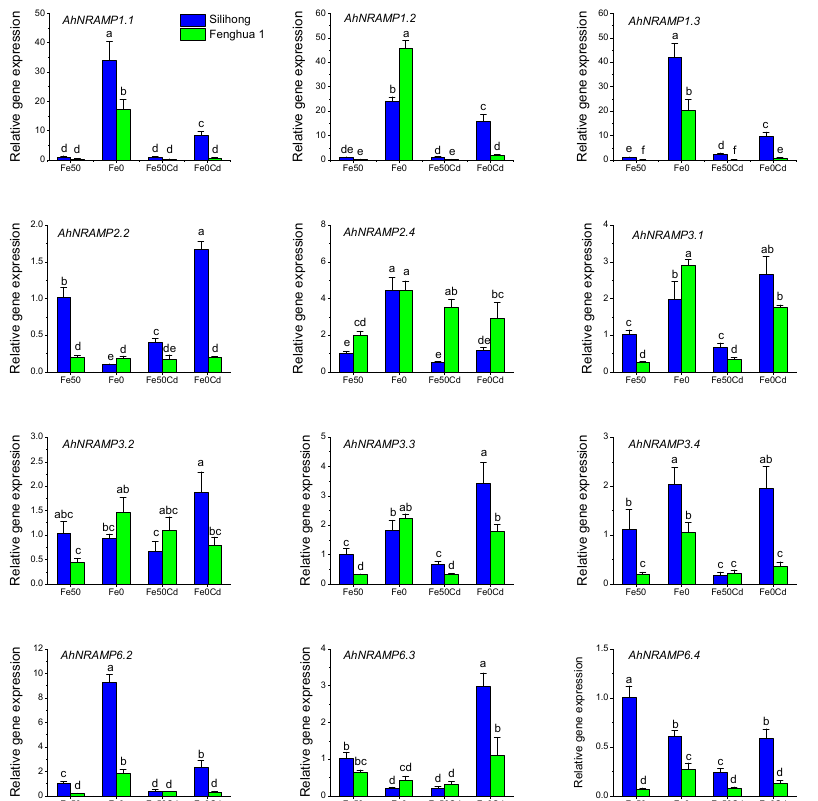
Figure 7. Expression levels of 12 AhNRAMP genes in peanut roots exposed to 0 or 2 μ M Cd under Fe-sufficient (Fe50) and Fe-deficient (Fe0) conditions for 14 days. Data (means ± SE, n = 3) sharing the same letter(s) above the error bars are not significantly different at the 0.05 level based on the Duncan multiple range test.